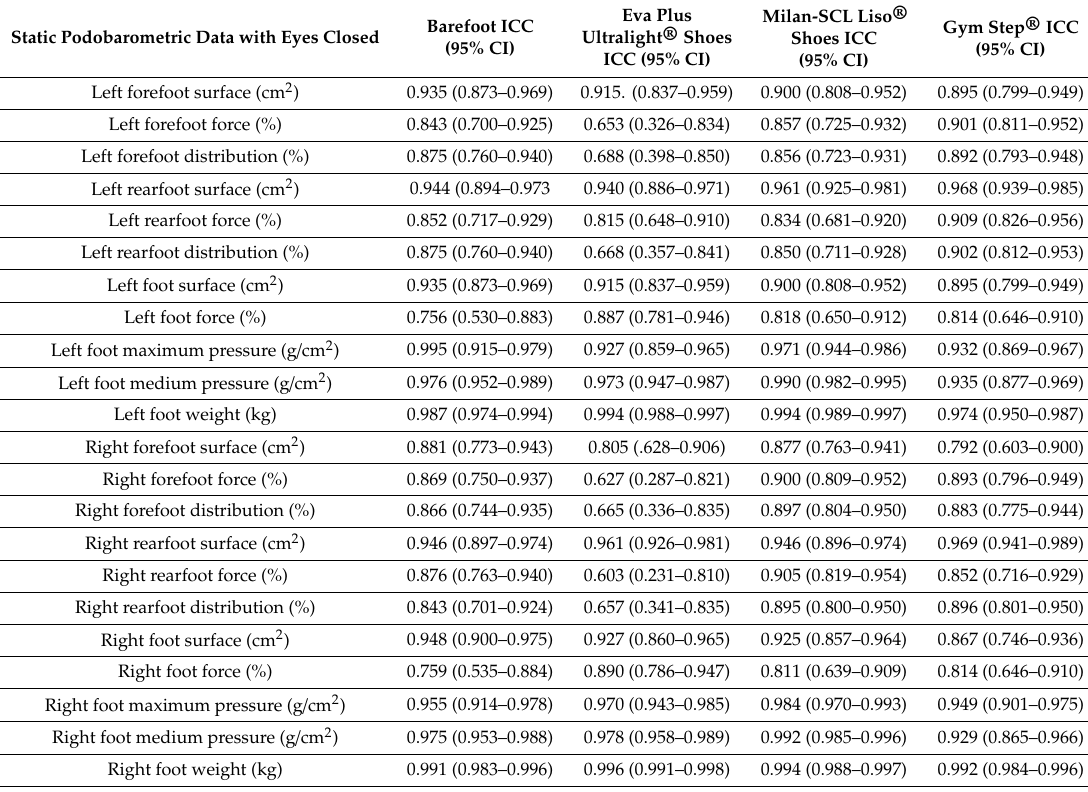
Table 6. Reliability of the static podobarometric data with eyes closed.